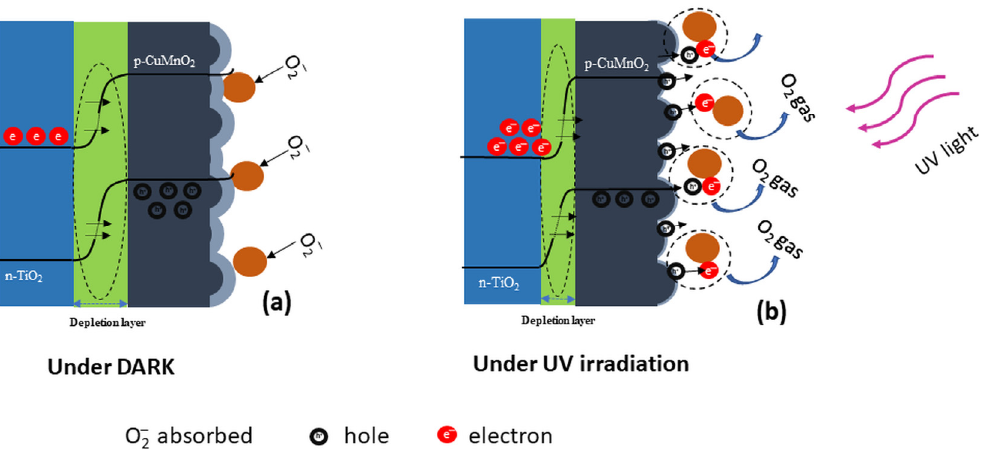
Figure 8. FTO-TiO 2 -CuMnO 2 in darkness ( a ); FTO-TiO 2 -CuMnO 2 in UV irradiation ( b ); band diagram of the FTO-TiO 2 -CuMnO 2 device at 0 V ( a ) in darkness and ( b ) under UV irradiation.